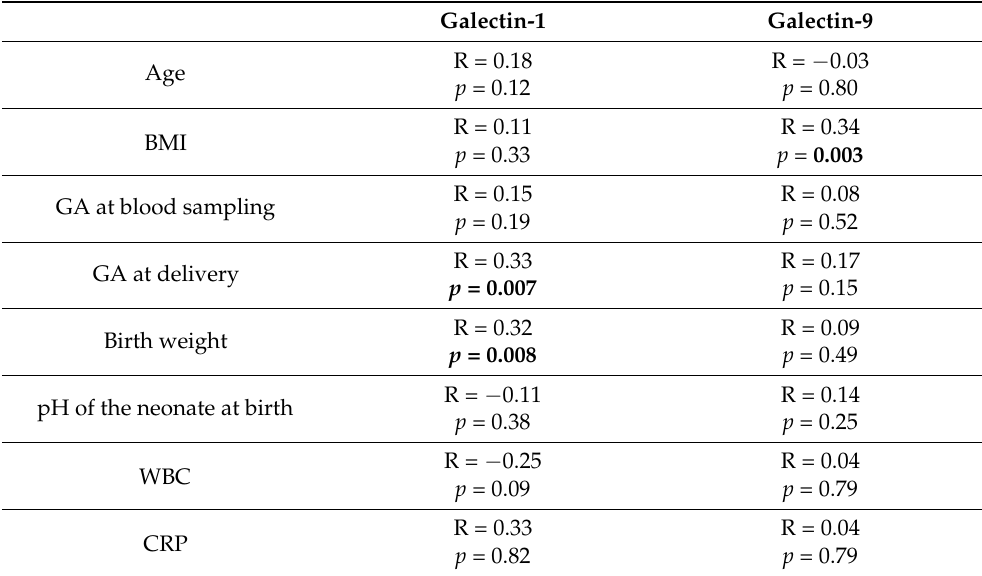
Table 3. Correlactions between galectins levels and other parameters. Spearman’s correlation analysis was used for galectin-1 and Pearson’s correlation analysis for